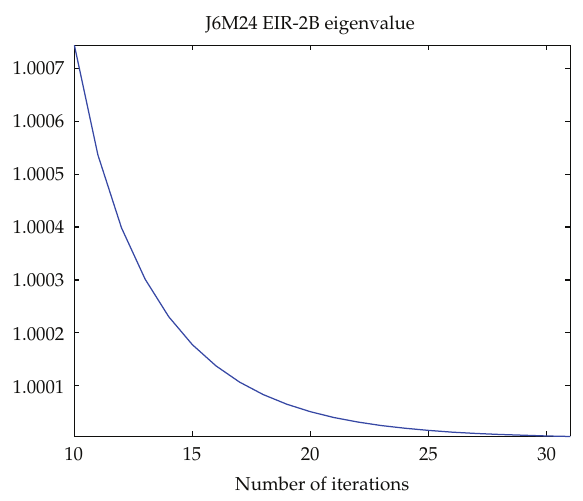
Figure 16: First eigenvalue in J6M24 EIR-2B.